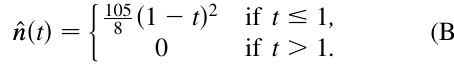
order derivatives of density) representing a better match with a Gaussian density than the previous one. The ^ nn (cid:7) t (cid:8) is based on the quadratic